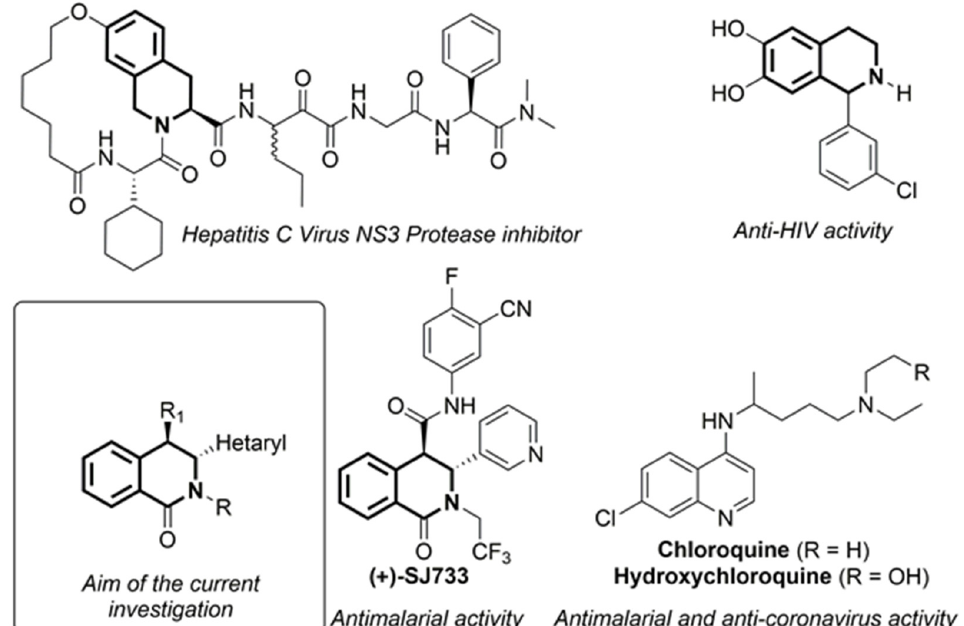
Figure 1. Structure of antiviral isoquinoline and quinoline derivatives and the target heterocyclic compounds of biological interest [5,6,12].